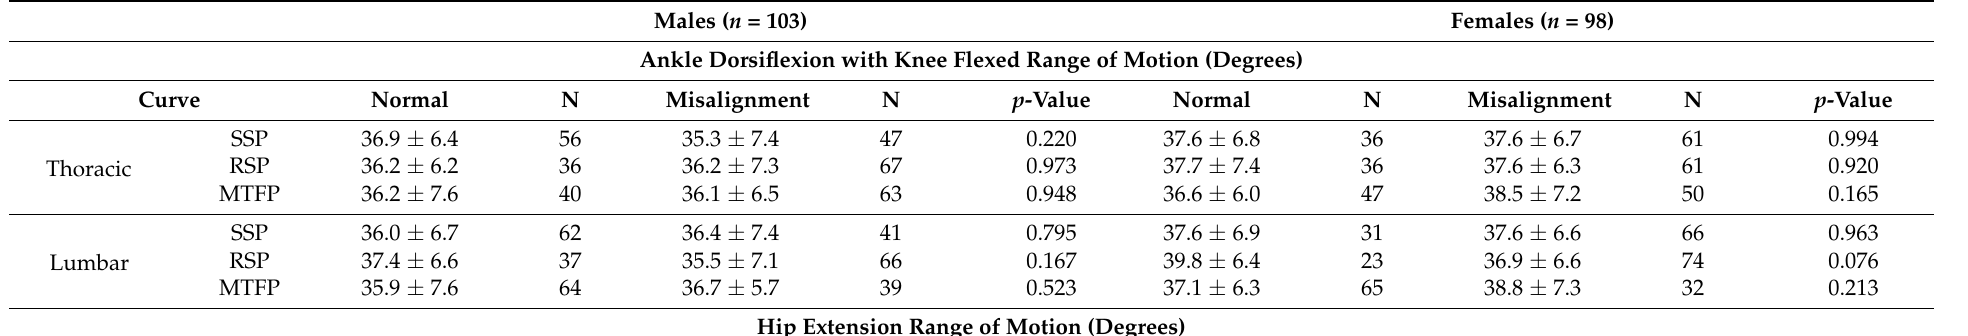
Table 2. Range of motion outcome data (mean ± SD) for normal and increased spinal curve in different postures according to gender. Males ( n = 103) Females ( n = 98) Ankle Dorsiflexion with Knee Flexed Range of Motion (Degrees) Curve Normal